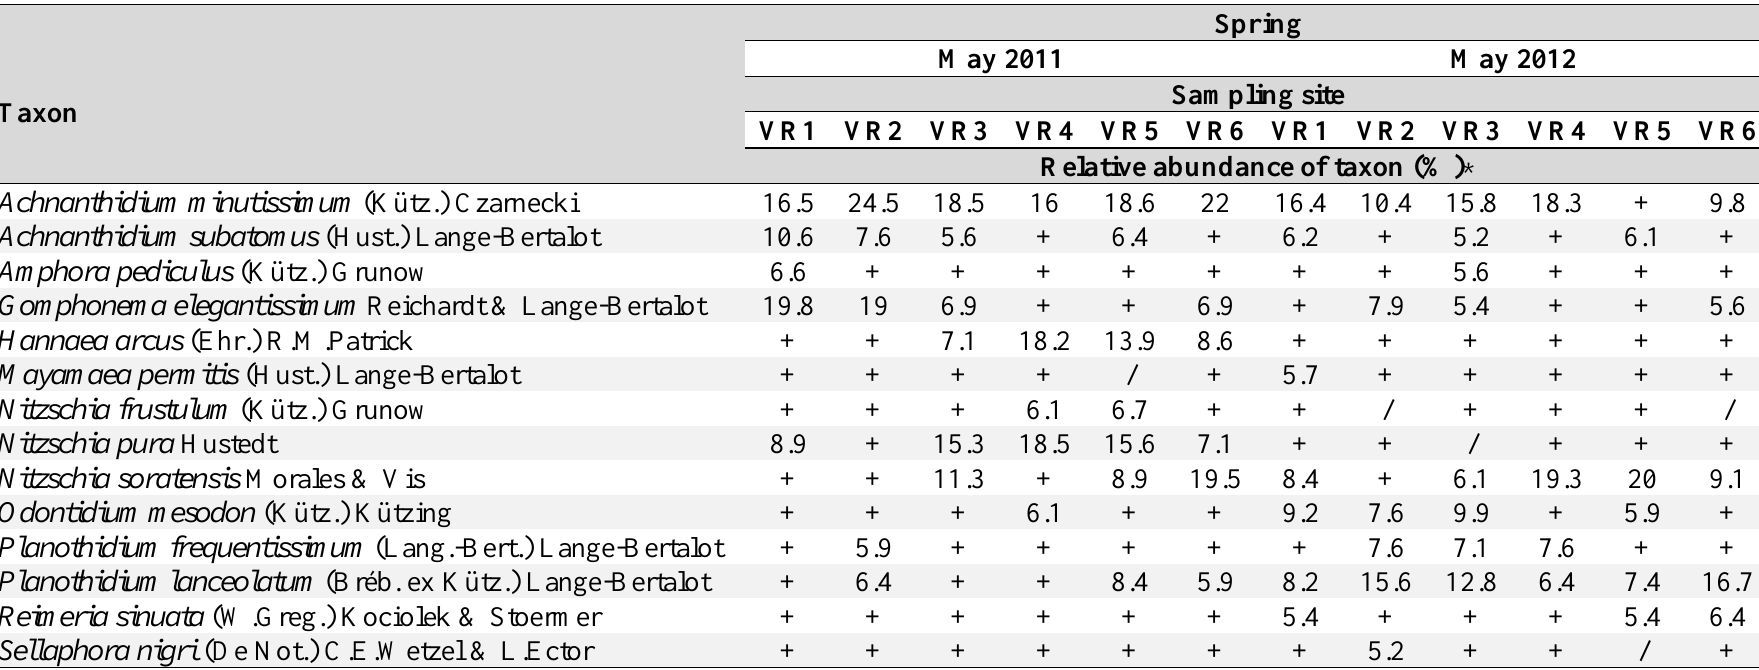
Table 1. Relative abundance of diatom taxa (%) present in the epilithic diatom community in the Vrla River during the spring period (May 2011 and